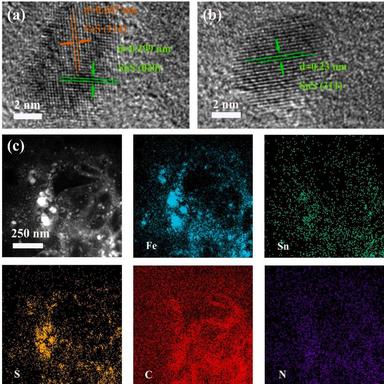
Morphology and structure characterizations. (a, b) HRTEM images, (c) STEM image of the SnS@FeS/C composite and the corresponding EDS element mapping images of Fe, Sn, S, C and N elements.